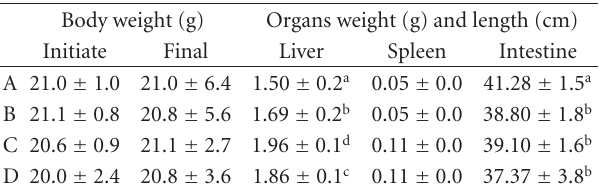
Table 1: Changes of body weight, organs weight, and intestine length of mice. Body weight (g)